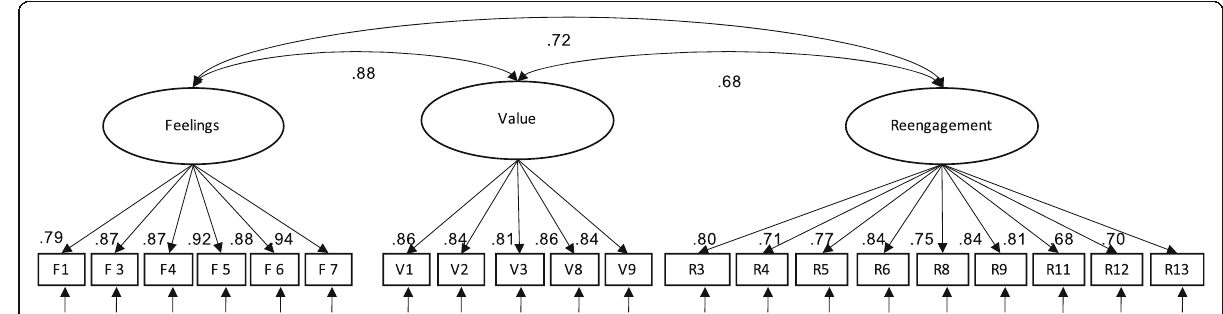
Fig. 1 Results from the final three-factor CFA model. Instrument items (for items descriptions see Table 1) are represented by squares, and factors are represented by ovals. The numbers below the double-headed arrows represent correlations between the factors; the numbers by the one- directional arrows between the factors and the items represent standardized factor loadings. Small arrows indicate error terms. p < 0.001 for all